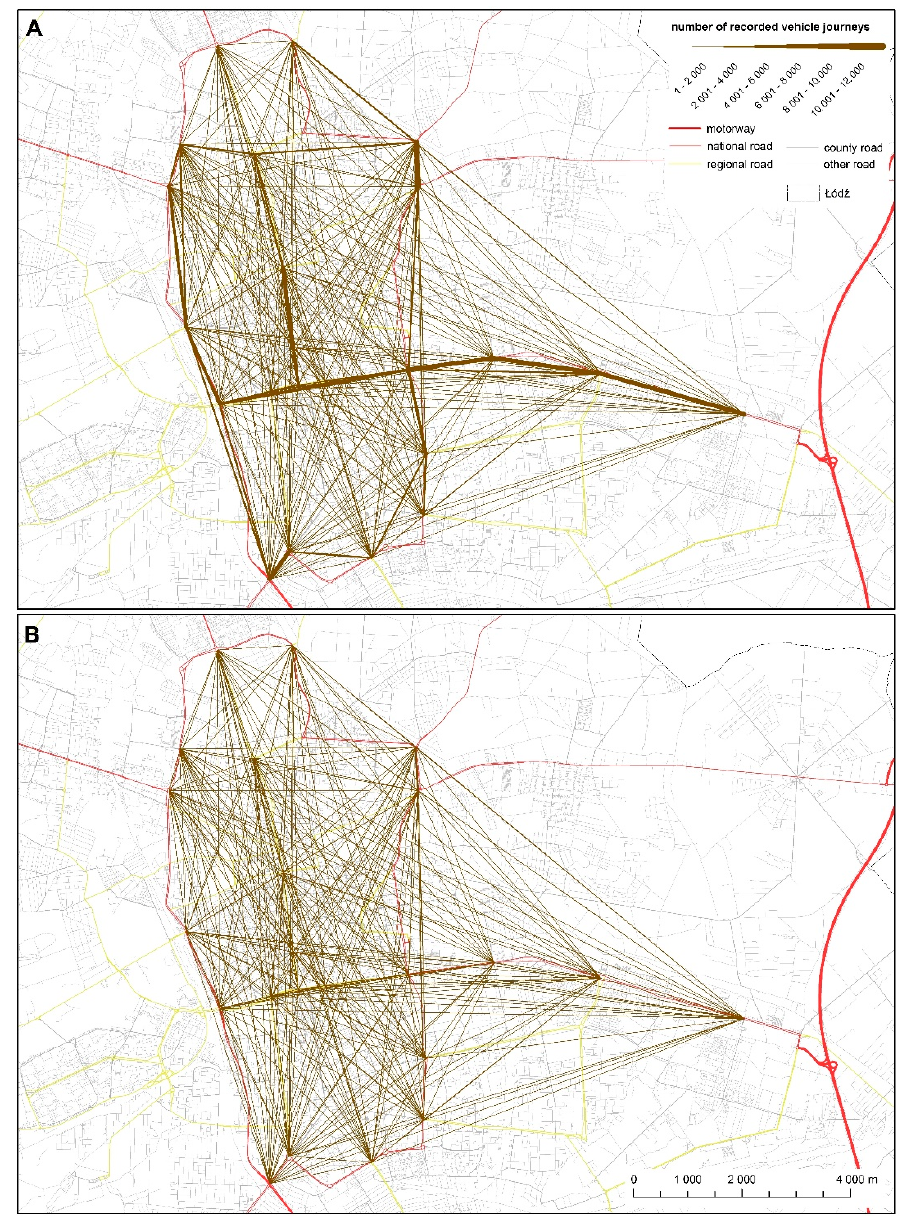
Figure 2. The average number of trips between the selected nodes of the Ł ód ź road network during afternoon rush hours from Tuesday to Thursday ( A ) and at weekends ( B ). Source: own elaboration based on the Database of Topographic Objects, OpenStreetMap, and the ANPR data collected by the ITS in Ł ód ź .